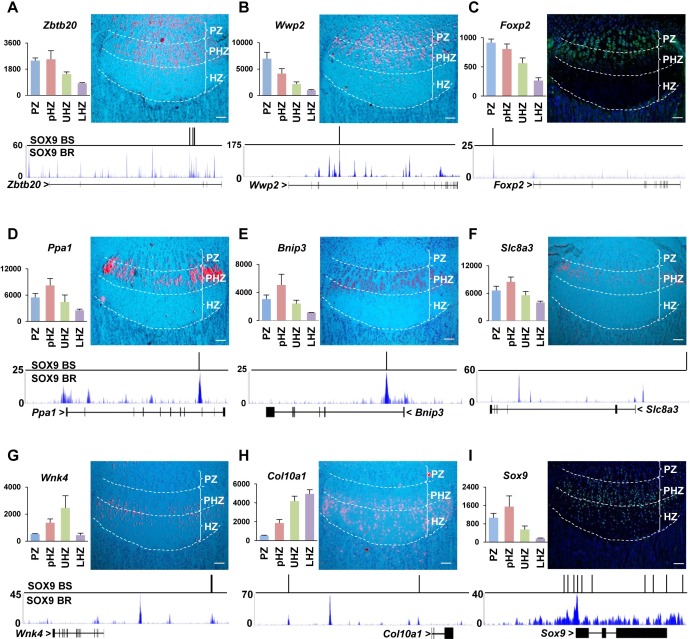
Expression patterns of putative SOX9 target genes and SOX9 binding regions in their genomic loci.(A-I) Genes with SOX9 binding motifs located within 200bp from SOX9 ChIP-seq peaks (Generated from newborn rib chondrocytes) were selected for validation. In vivo expression patterns of potential SOX9 targets were validated by in situ hybridization: Zbtb20 (A), Wwp2 (B), Ppa1 (D), Bnip3 (E), Slc8a3 (F), Wnk4 (G) and Col10a1 (H); or immunostaining: FOXP2 (C) and SOX9 (I), revealing similar expression trends with the microarray data as shown on the left side. The PZ, PHZ and HZ were separated by the white-dot lines. (Bar = 100μm). Predicted SOX9 binding sites (BS: binding site) and SOX9 ChIP-seq signals (BR: binding region) (Green) are shown under each gene.